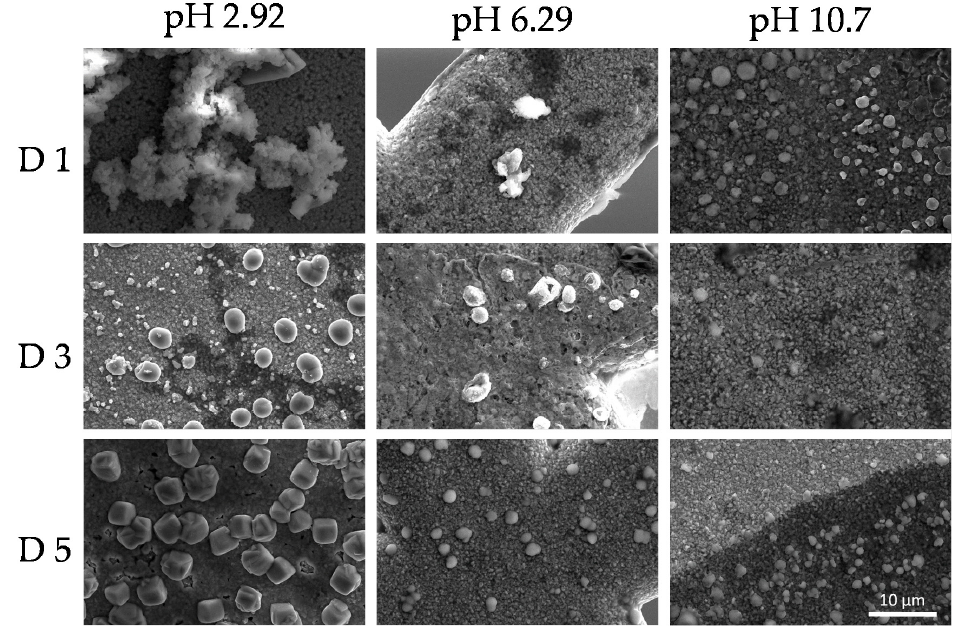
Figure 9. Scanning electron microscopy (SEM) micrographs at a magnification ×5000 of the colloids (PKHEDA 1 × 10 ⁻ 4 M/TPPS 5 × 10 ⁻ 5 ) at three different pH (2.92, 6.29, and 10.70) during five days (day 1 = D1, day 3 = D3, day 5 = D5).